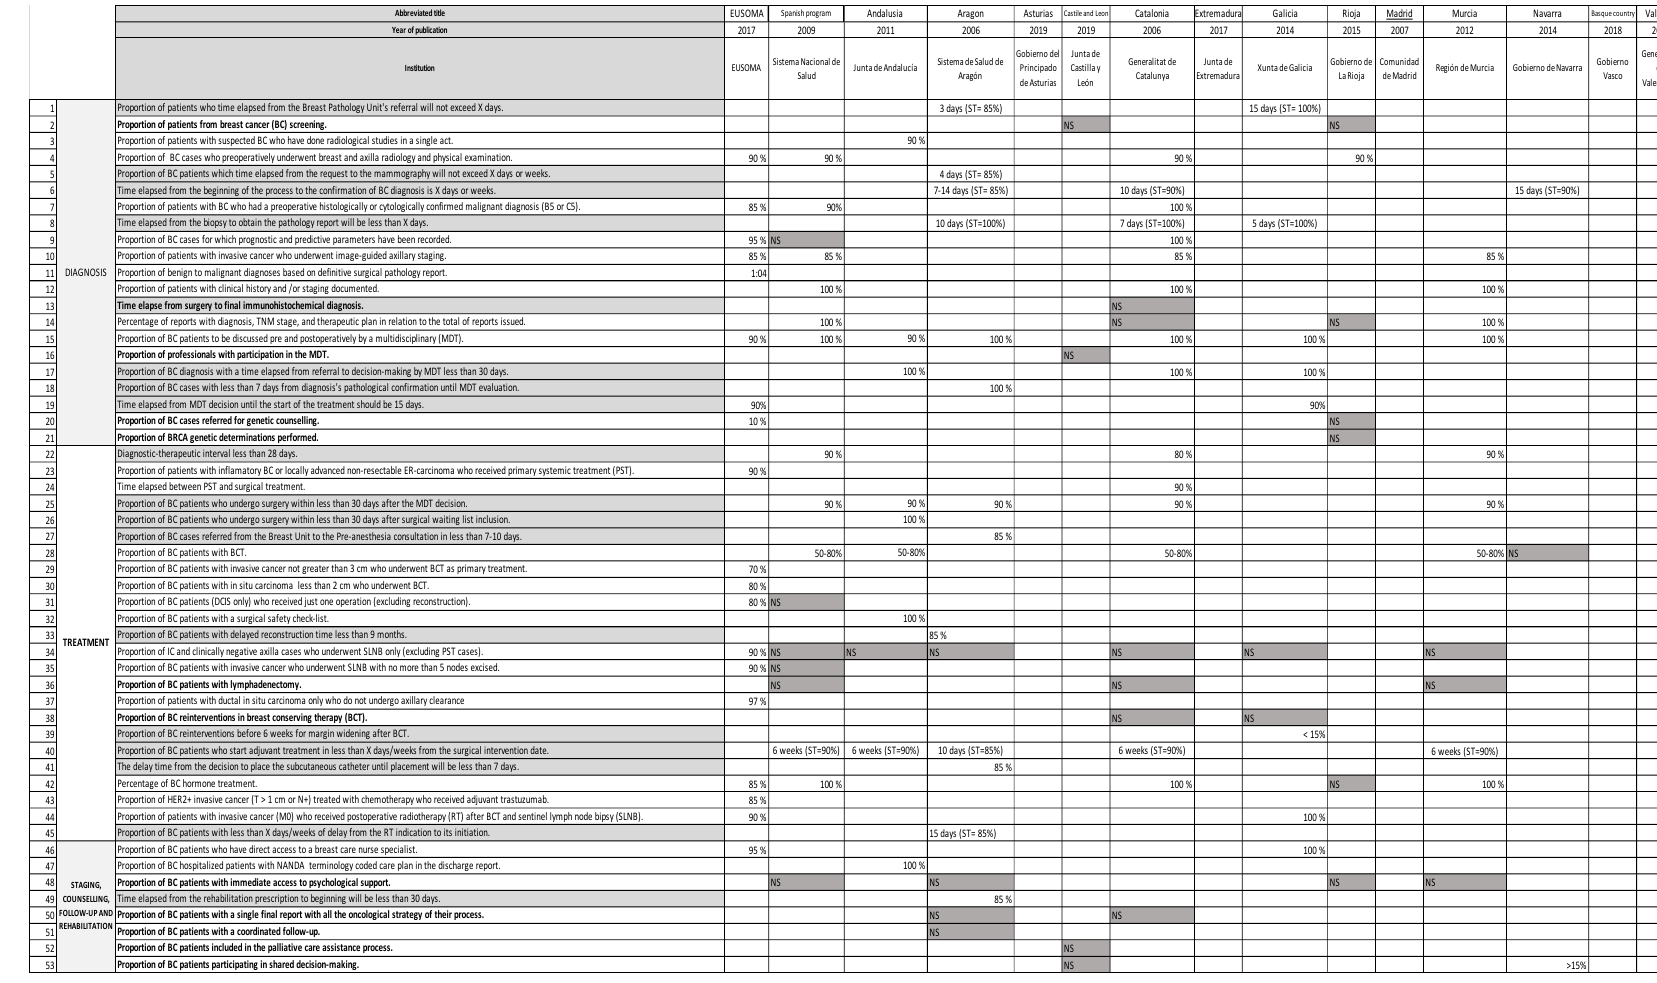
Figure 3. Comparison of the standards of the breast cancer care quality indicators related to the process among the Spanish integrated breast cancer health care processes and clinical pathways analysed. NS in grey means “standard not specified” .